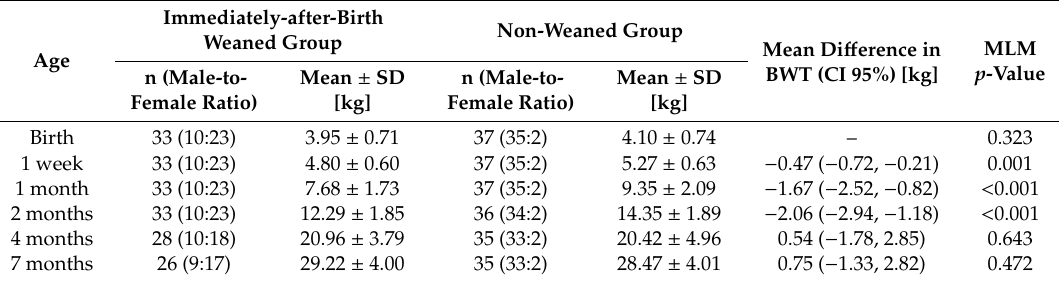
Figure 1. Body weight and daily body weight gain of kids (shown as means and SD) during the study period. The di ff erence significant at α = 0.05 is indicated by an asterisk (*). Table 1. Body weight (BWT) of kids, shown as mixed linear model-estimated means and standard deviation (SD) during the study